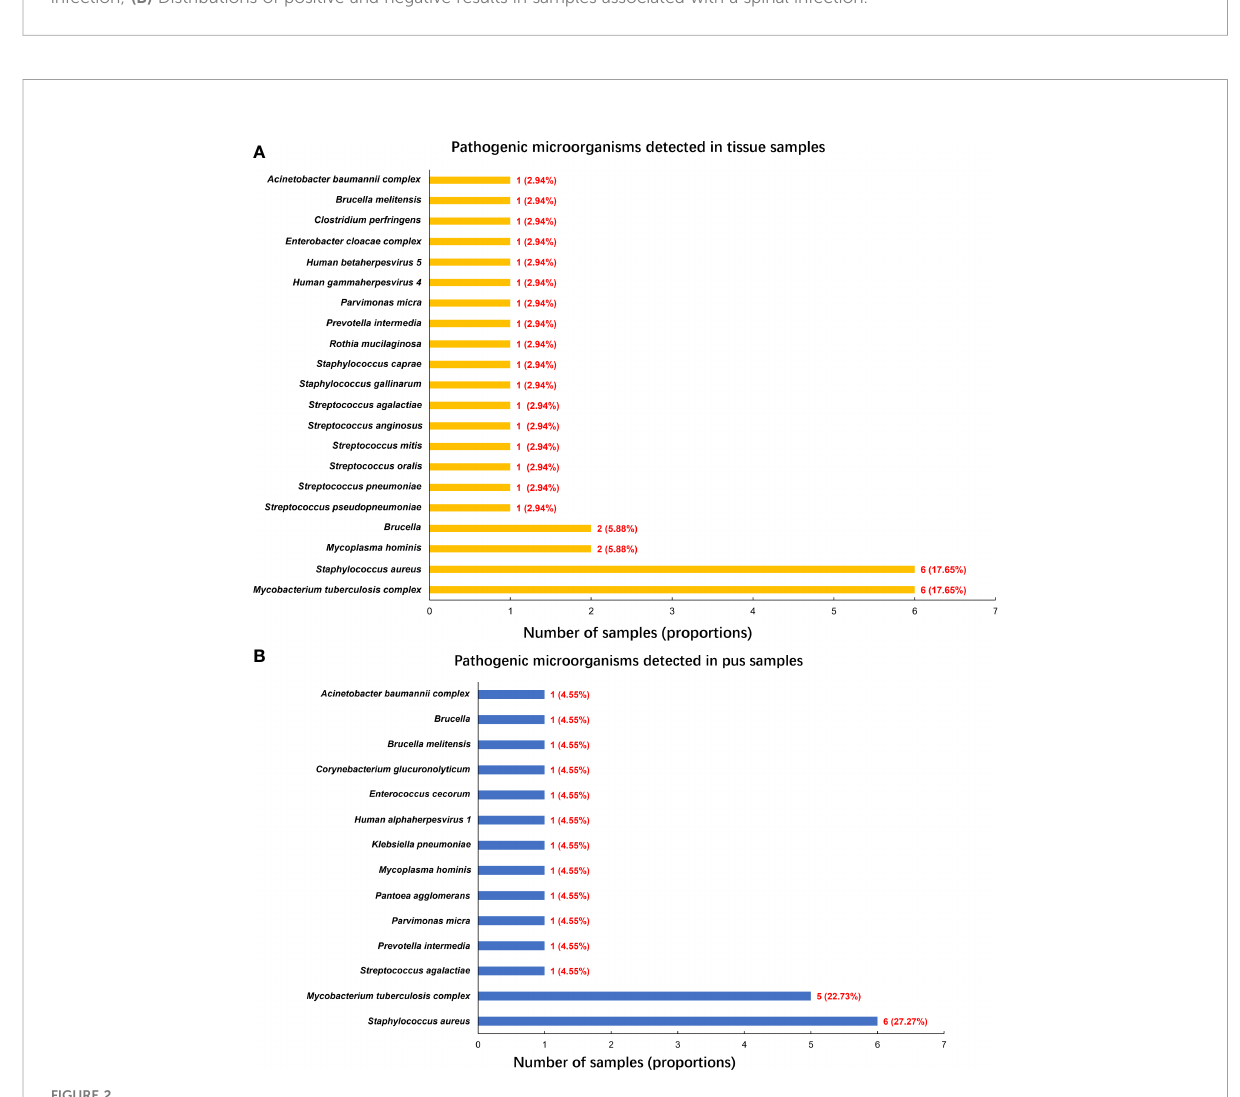
FIGURE 2 Pathogenic microorganisms detected by mNGS. (A) Pathogenic microorganisms detected in tissue samples; (B) Pathogenic microorganisms detected in pus samples.